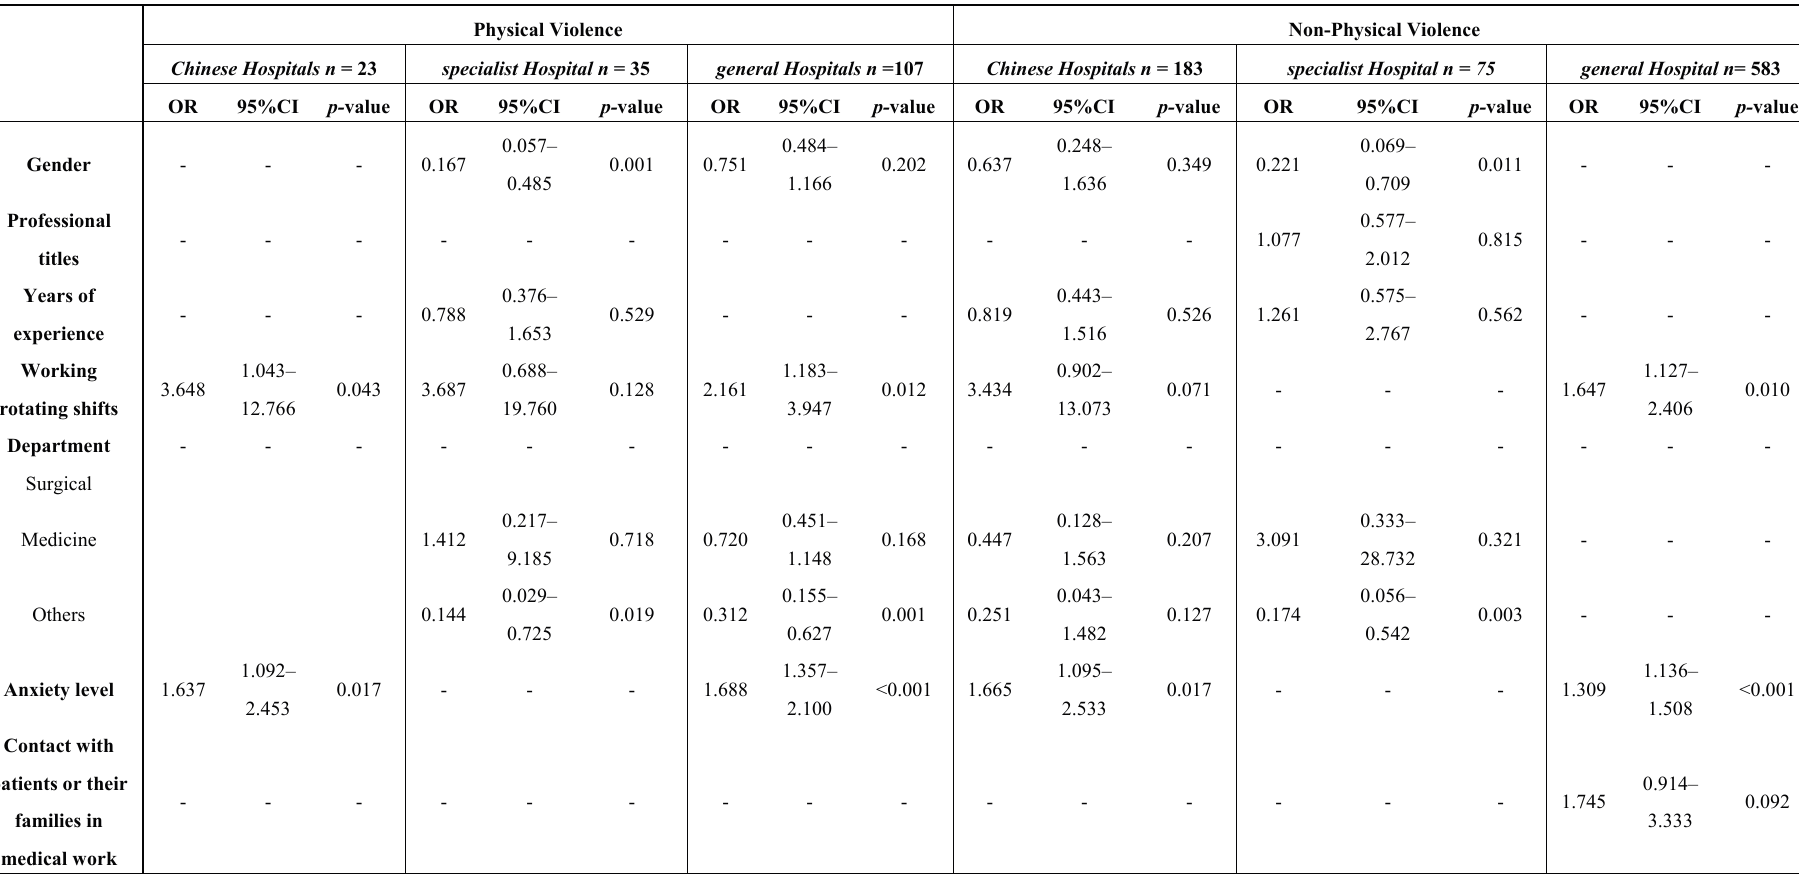
Table 5. Multiple logistic regression of physical and non-physical violence in Chinese hospitals, specialist hospital, general hospitals * . Physical Violence Non-Physical Violence Chinese Hospitals n =